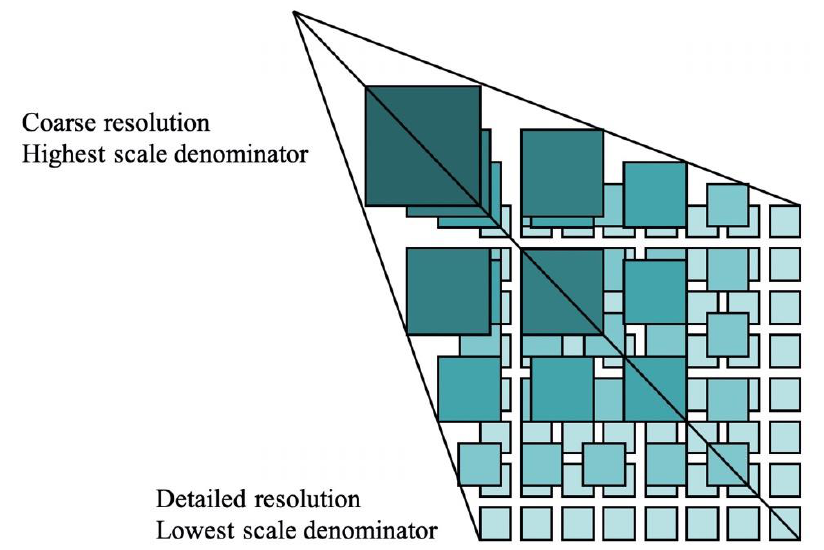
Figure 4. Multi-level tiled, or pyramidal, image (Copyright 2019 Open Geospatial Consortium). At each zoom level z , the global map for the Earth surface is divided in 2 z visualization tiles, and each tile has a size of 256 × 256 pixels, since each tile is an image, traditionally a portable network graphics (PNG) type. At each zoom level, the tiles are numbered according to their location along the west–east, the x coordinate, and north–south axis, the y coordinate.